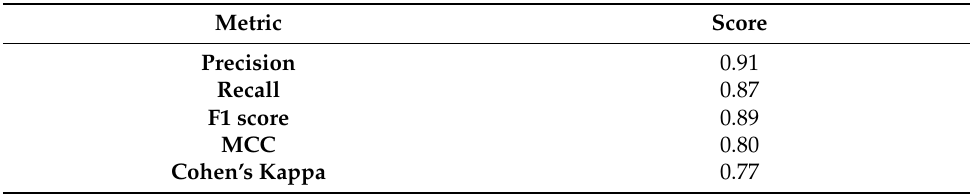
Figure 4. CRISP–RCNN prediction performance. ( a ) The precision–recall (PR) curve for CRISP– RCNN has an area under the curve (AUC) of 0.88, and performs better than the other dual-sequence- based classifier in the comparison, which has an AUC of 0.71, reported by Lin et al., 2018 [35]. ( b ) The F1-MCC curve indicating robust performance even on the imbalanced dataset; the points indicating the best- and worst-possible prediction performance are also highlighted. In plots (a,b), the dashed line indicates random prediction, i.e., 50% accuracy. ( c ) The R 2 value for the CRISP–RCNN regressor is 0.71, showing better performance than a previous guide RNA prediction model built on sequence and physicochemical parameters, which shows an R 2 value of 0.49 [36]. Table 3. Performance scores for various metrics of the best-performing model (CRISP–RCNN), measured on the held-out test